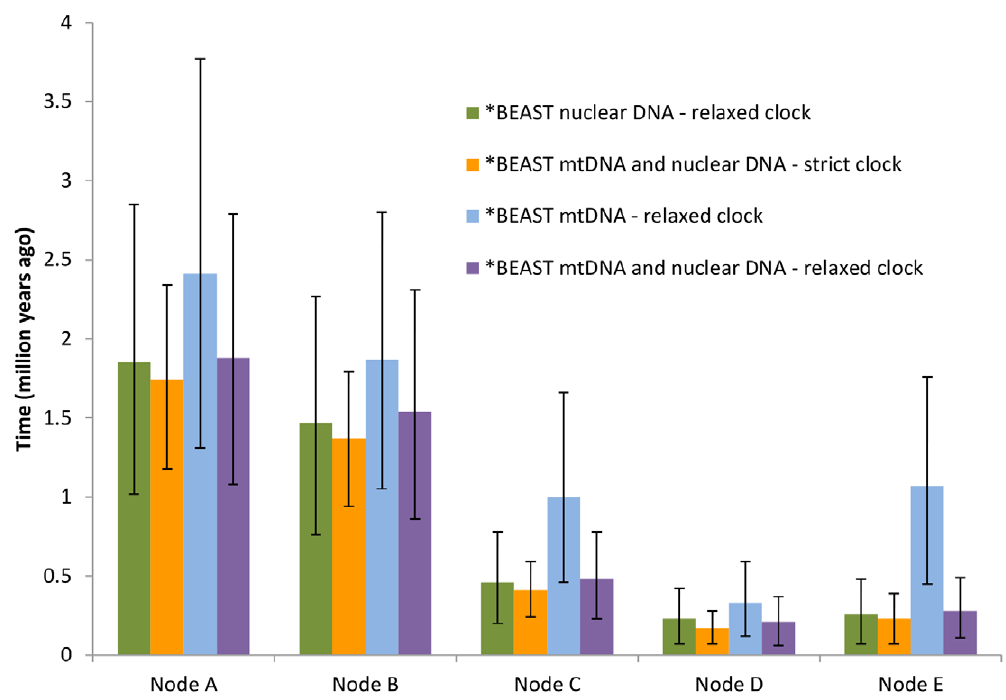
Figure 3. *BEAST speciation times estimated from the Cardinalis cardinalis species tree. Speciation time estimates using differing parameters and data sets: green - speciation times estimated from nuclear DNA using relaxed clocks, orange - speciation times estimated from mtDNA and nuclear DNA using strict clocks, light blue - speciation times estimated from mtDNA only using a relaxed clock, and purple - speciation times estimated from mtDNA and nuclear DNA using relaxed clocks. The nodes are from the C. cardinalis species tree: Node A) carneus – all other lineages; Node B) igneus / mariae – cardinalis / coccineus / saturatus ; Node C) cardinalis – coccineus / saturatus ; Node D) saturatus – coccineus ; Node E) mariae–igneus